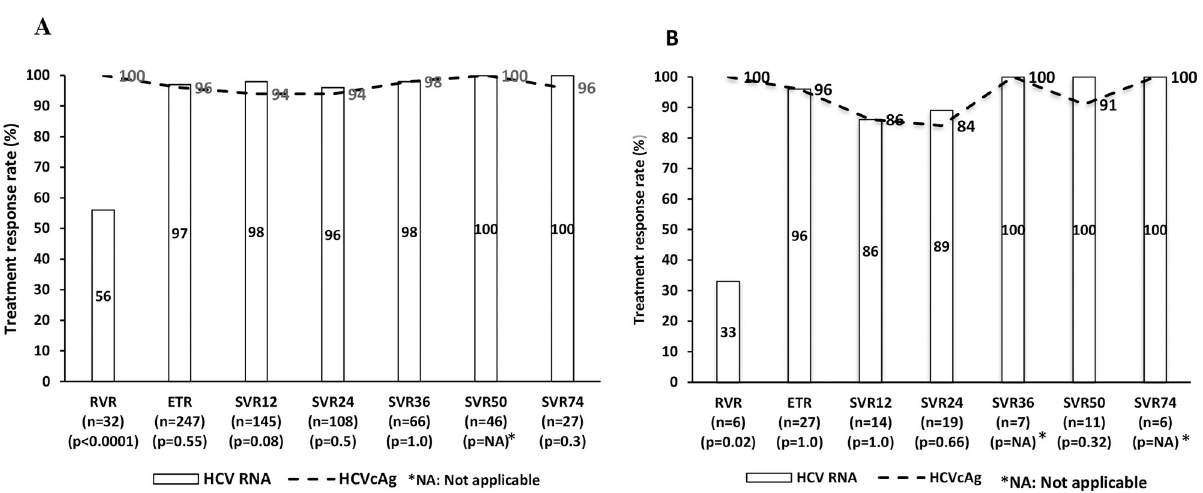
Fig 2. Treatment response rate assessed by HCV RNA & HCVcAg at various time points. (A)Treatment-na ï ve (n = 383). Mean HCVcAg levels (log IU/mL) in HCV RNA negative individuals at ETR (n = 6), SVR12 (n = 5), SVR24 (n = 2) & SVR74 (n = 1) are 3.8, 3.7, 3.5 & 3.39 respectively. (B) Previously treated (n = 40). HCVcAg levels (log IU/mL) in HCV RNA negative individuals at SVR24 (n = 1) & SVR50 (n = 1) are 4.1 & 3.46 respectively. Abbreviations: HCV, hepatitis C virus; HCVcAg, hepatitis C virus core antigen; RVR, rapid virological response; ETR, end of treatment response; SVR, sustained virological